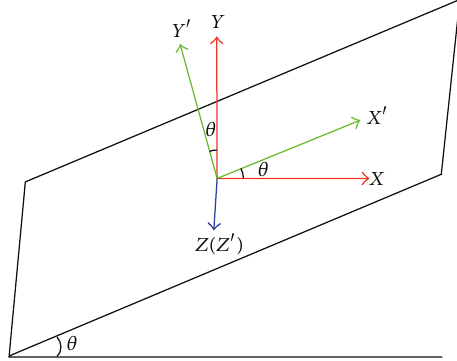
Figure 8: Schematic drawing showing coordinate transformation